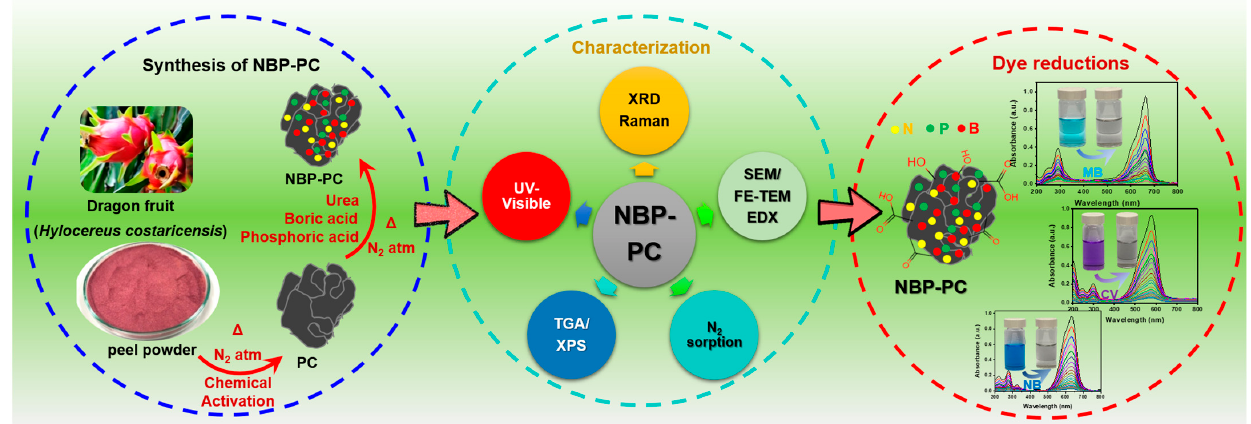
Scheme 2. Schematic diagram illustration of the preparation (left), characterization (middle), and application (right) of NBP-PCs.